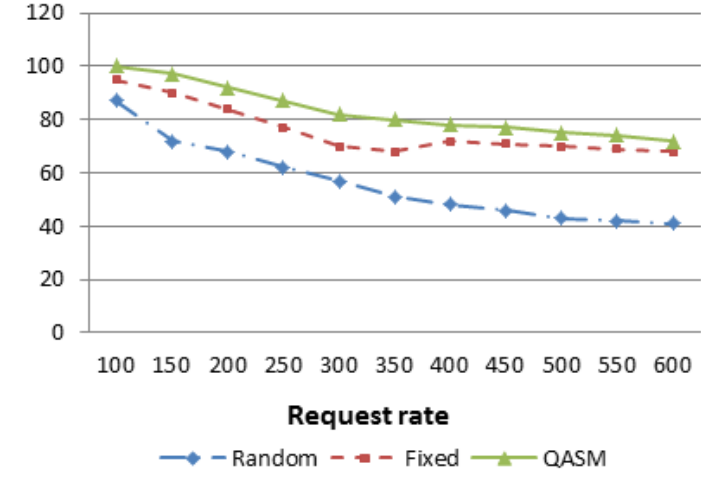
Figure 7. Throughput under different system load (load